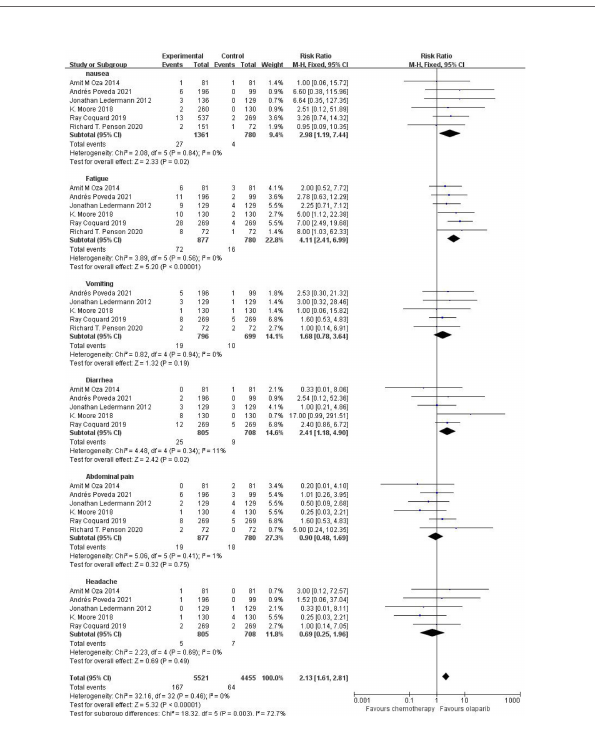
FIGURE 3 | Meta-analysis results of adverse reactions of any grade between control group and olaparib group.